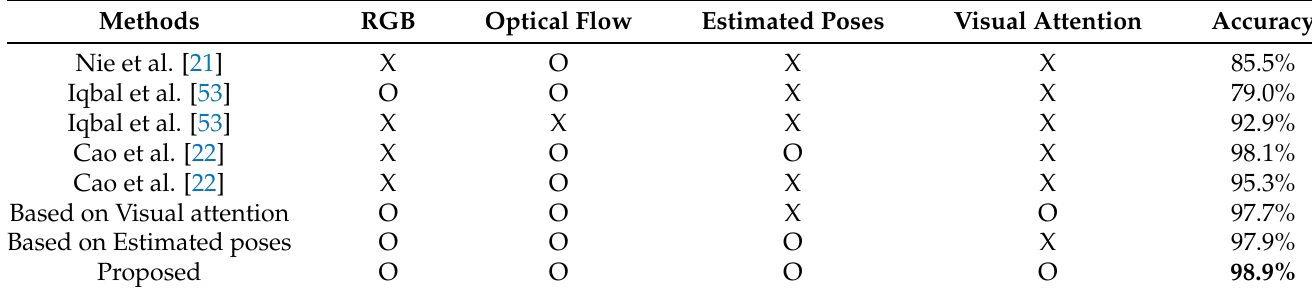
Table 2. Experimental results with the Penn Action dataset.